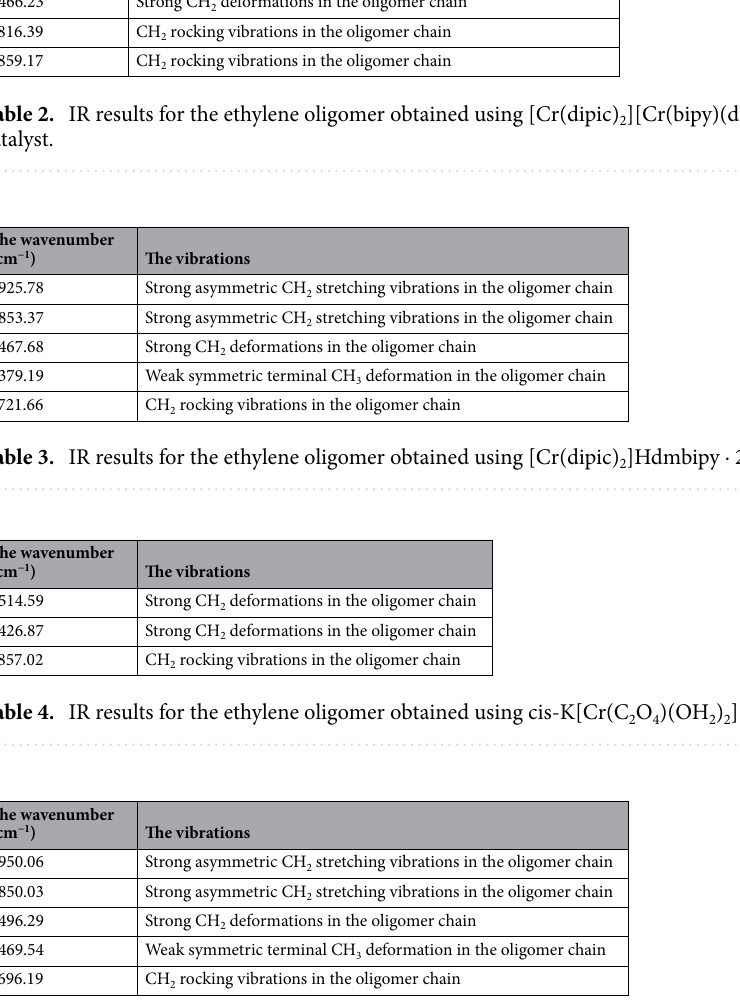
Table 5. IR results for the ethylene oligomer obtained using [Cr(dipic)(H 2 O) 3 ]Cl ∙ 2 H 2 O as a catalyst.